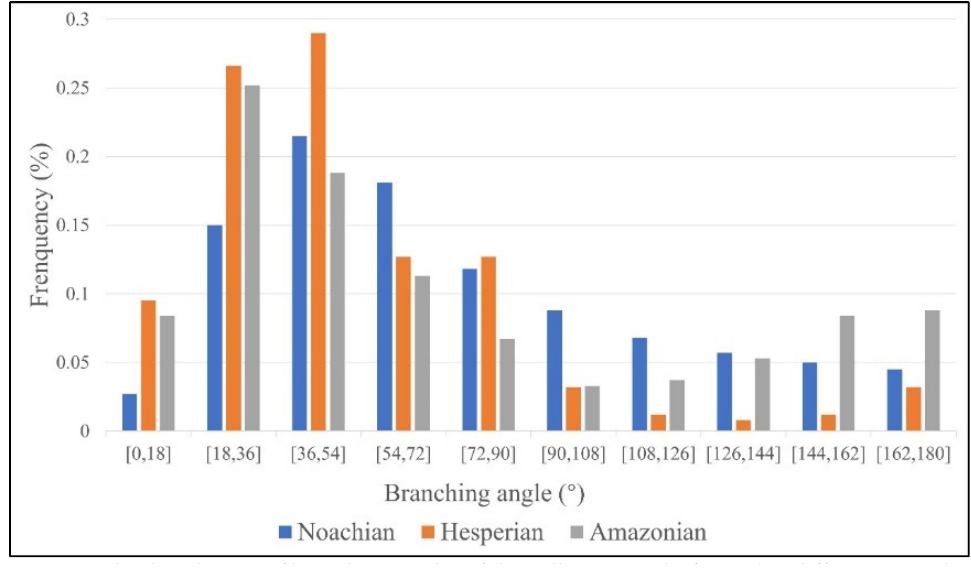
Figure 6. The distribution of branching angles of the valley networks formed in different periods on Mars.